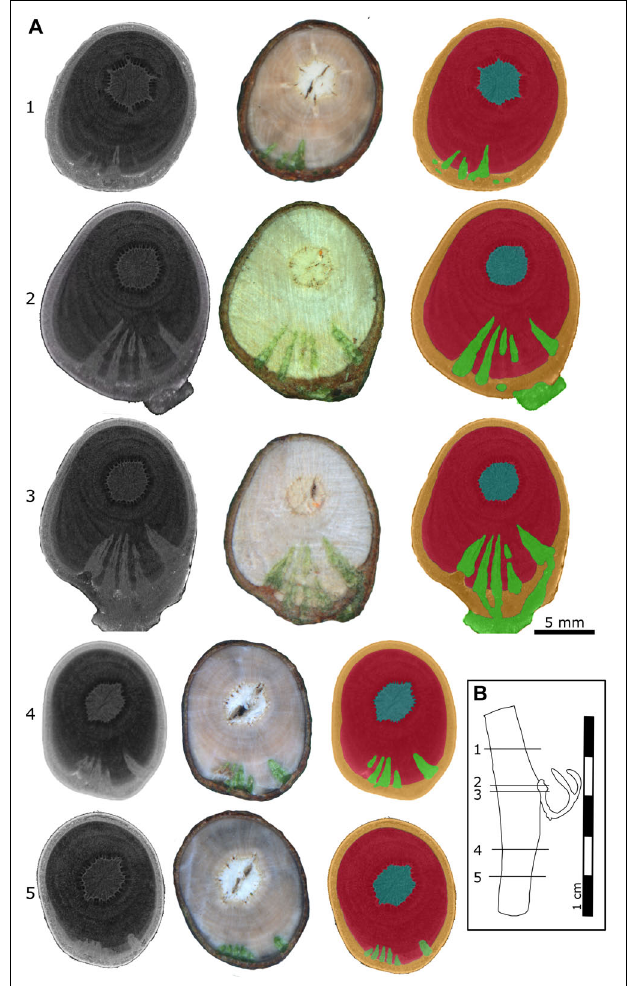
FIGURE 4 | Location of a 4-year-old mistletoe endophyte inside the host branch. (A) Transverse sections of the host branch. Images were taken with a microCT (first column) and a stereo microscope (second column). The third column shows the microCT scan recolored by hand according to the stereomicroscopic images. Blue: host pith, red: host wood, orange: host cortex, green: mistletoe. The positions of the individual sections (1–5) are marked in the sample outline in panel (B) . (B) Outline of the host branch showing the position of the five transverse sections from apical (1) to basal (5). Parts of the exophyte had broken off during cutting, as is visible in its mildly different shape in sections 2 and